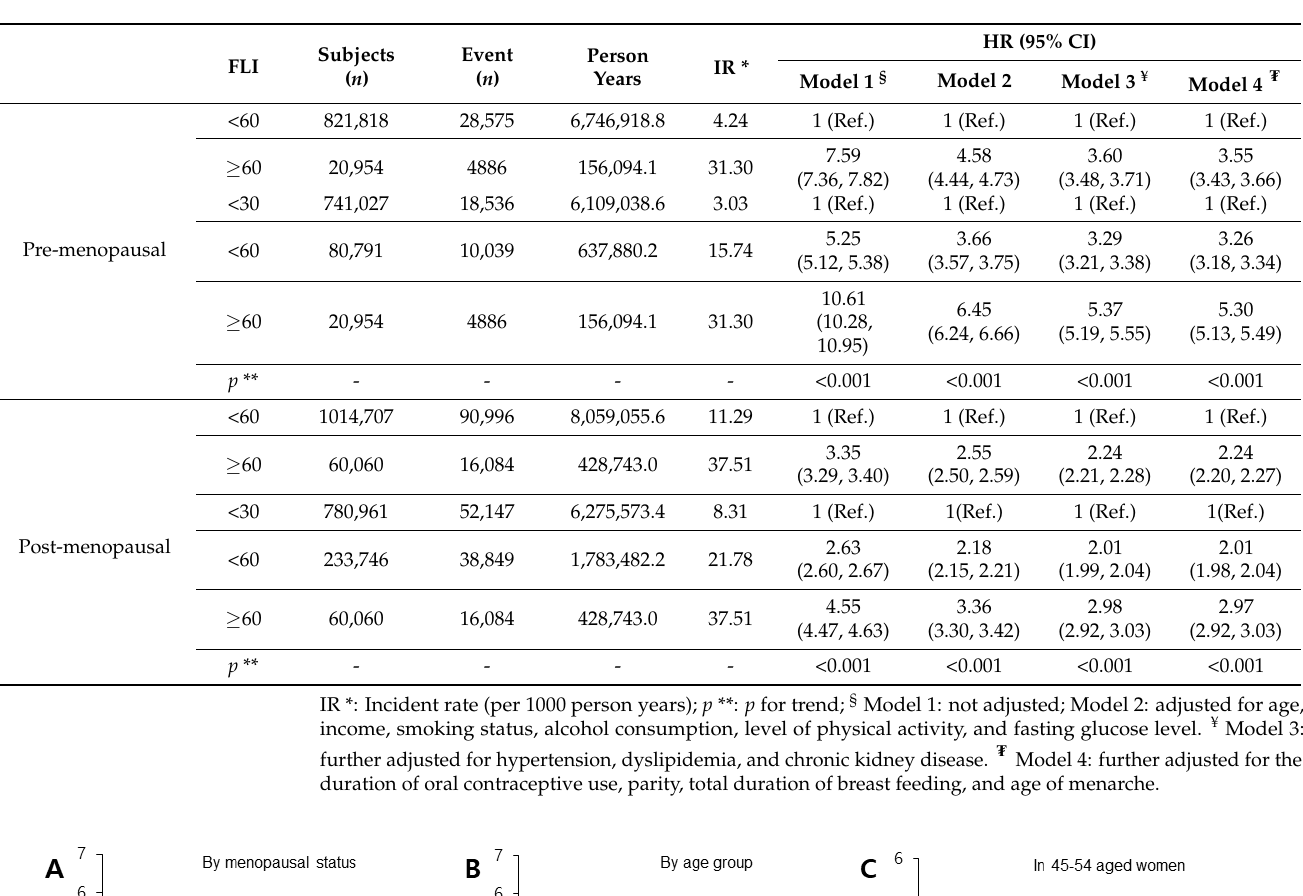
Table 3. Associations between fatty liver index and type 2 diabetes mellitus risk by menopausal status.